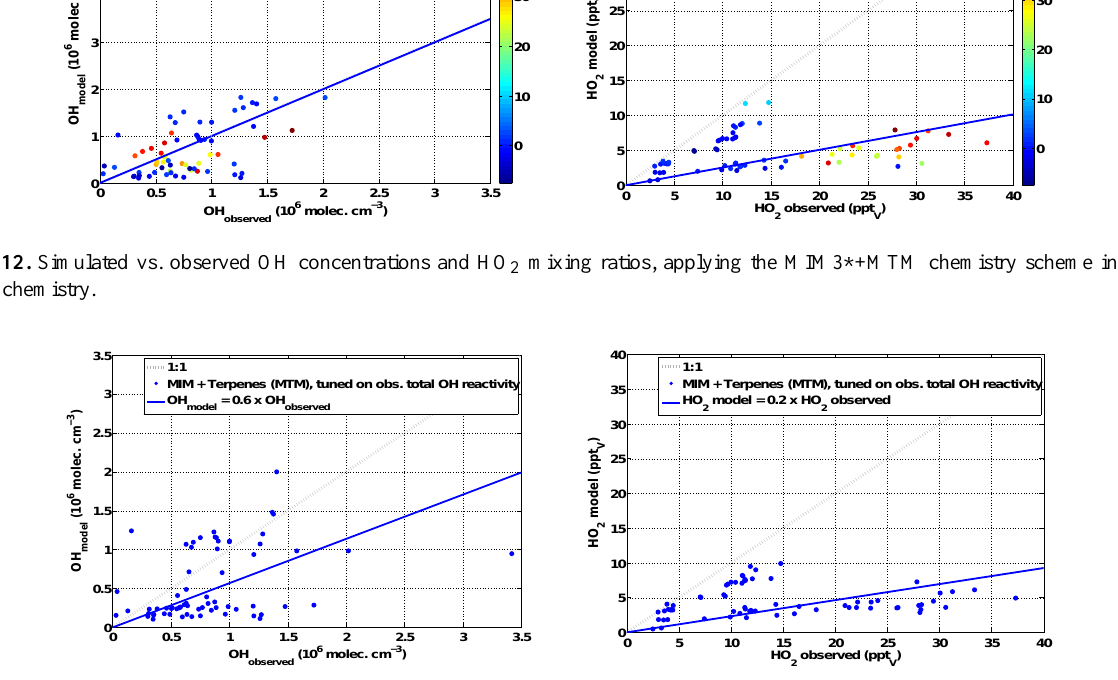
Fig. 13. Simulated vs. observed OH concentrations and HO 2 mixing ratios, applying the MIM3*+MTM chemistry scheme and tuning the model to the observed total OH reactivity by introducing an additional α -pinene